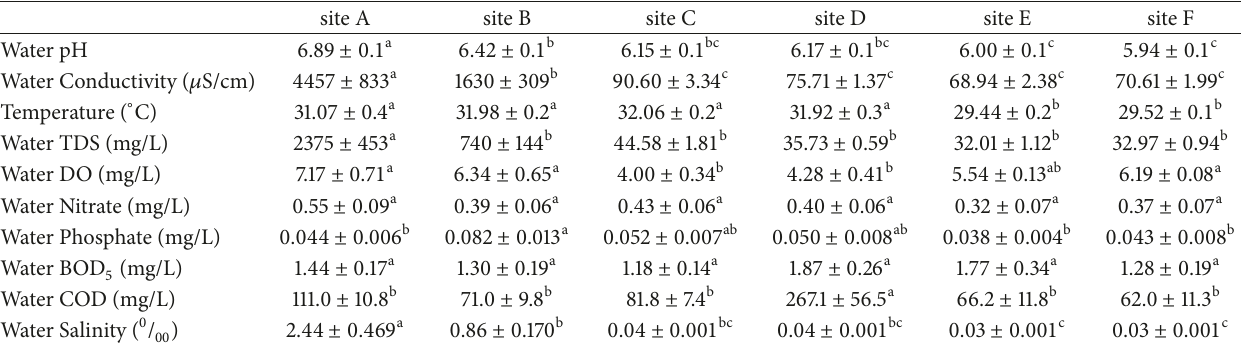
Table 1: Spatial variation of water quality parameters in sampling sites during the study period. Data are presented as mean ± standard deviation (SD). Results indicated by different superscript letters in each row are significantly different from each other (ANOVA, Tukey’s test, p < 0.05,